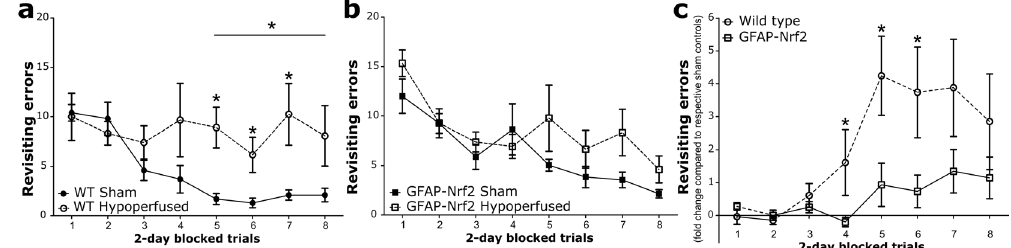
Figure 2. Cerebral hypoperfusion causes an impairment in behavioural performance in wild type mice which is less pronounced in GFAP-Nrf2 mice. Spatial behaviour was assessed by the radial arm maze as revisiting errors over consecutive trials. ( a ) Wild type (WT) hypoperfused animals committed significantly more revisiting errors than WT shams during blocks 5–8 (F (1,9) = 6.56, p = 0.03). ( b ) GFAP-Nrf2 hypoperfused animals did not make significantly more revisiting errors than the GFAP-Nrf2 shams during blocks 5–8 (F (1,17) = 3.81, p = 0.07) ( c ) Revisiting error fold difference compared to respective sham controls was used to investigate genotype effect and analysis revealed a significantly higher fold difference in wild type mice (F (1,13) = 4.79, p = 0.048). Mean ± SEM. Repeated measures ANOVA with Bonferroni adjustment for post hoc analysis. * p < 0.05. n = 5–10 per